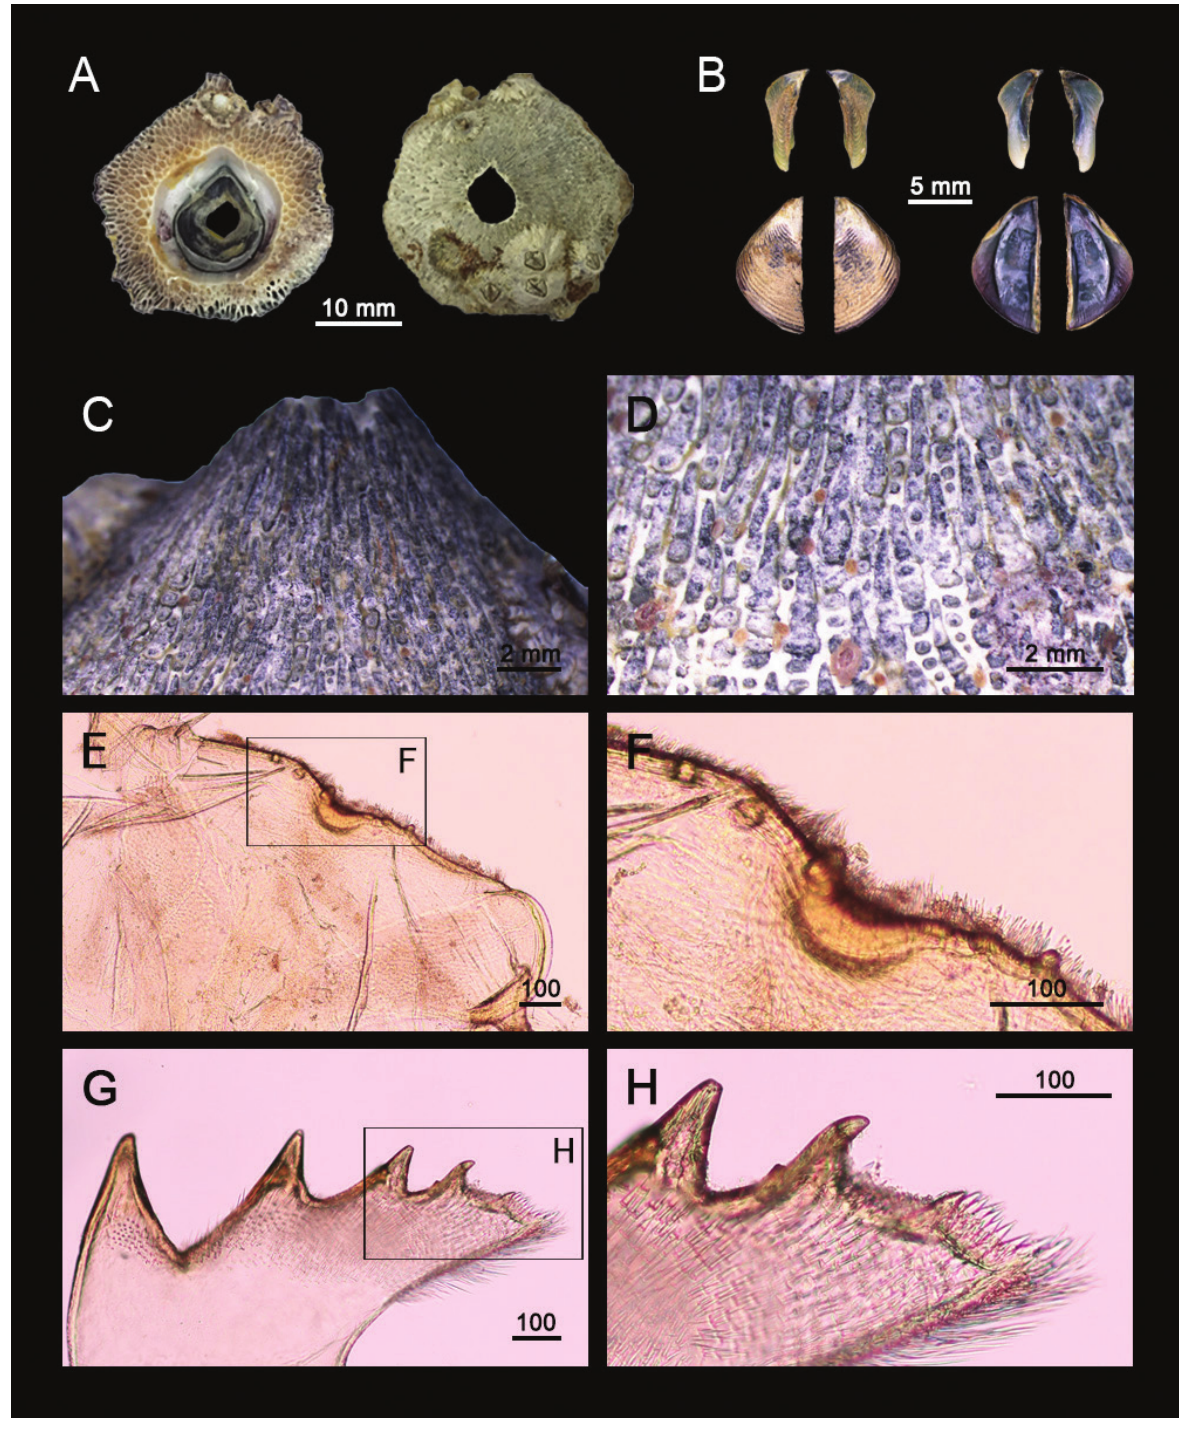
Figure 7. Tetraclita singaporensis collected from (BUU16.TC.TSG02) from Na Tai beach, Phang-nga. A. Dorsal and ventral view of external shell, B. External (left panel) and internal (right panel) view of tergum (upper panel) and scutum (lower panel), C. Lateral side showing external surface of shell, D. Close up on the external surface of shell, E–H. Light microscopy on mouthparts, E. Labrum, E. Close up on the teeth of the labrum, G. Mandible, G. Close up on the pectinated lower margin of mandible. E–H. Scale bars in